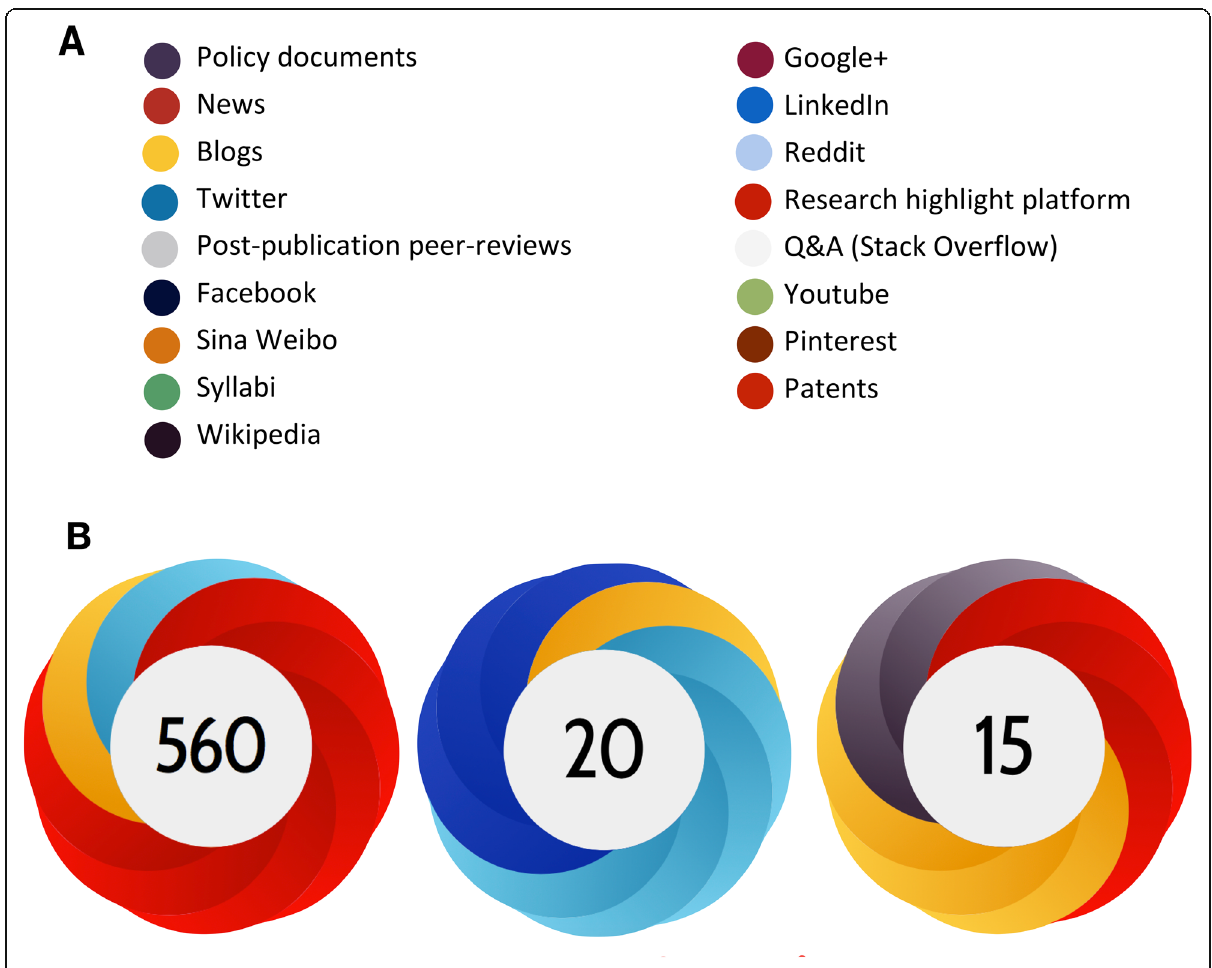
Fig. 1 a Sources tracked by the Altmetric Explorer. b Altmetric donut examples. The prevalence of red colors in the Altmetric donuts indicates that the research outputs received the most online attention from mainstream media, light and dark blue indicates that the item received mainly tweets and Facebook mentions, yellow and grey indicates Wikipedia and blogs activity, while purple is linked to policy documents mentions (starting from the left to the right). AAS is displayed in the center of each